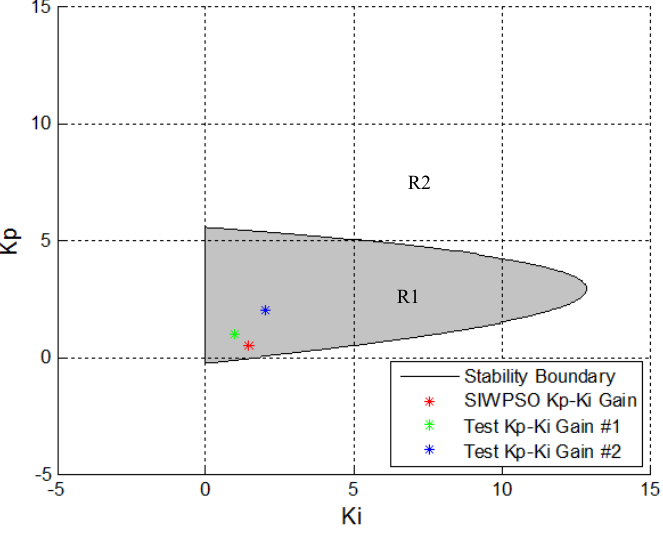
Figure 9. Stability regions of PID controller for Equation